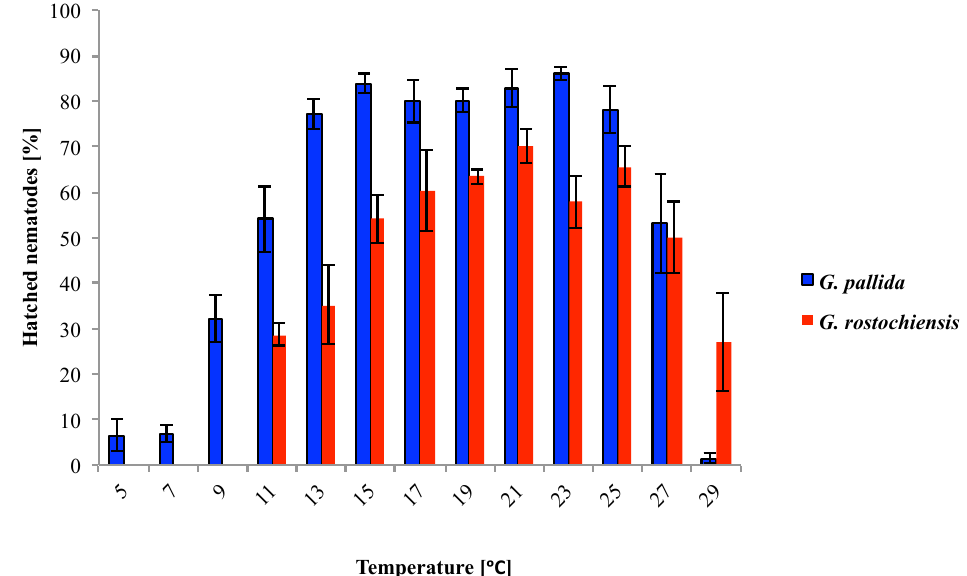
Figure 1. Mean total proportions of hatched Globodera rostochiensis and G. pallida in potato root diffusate, during 35 d incu - bation at different temperatures. Bars indicate standard errors of